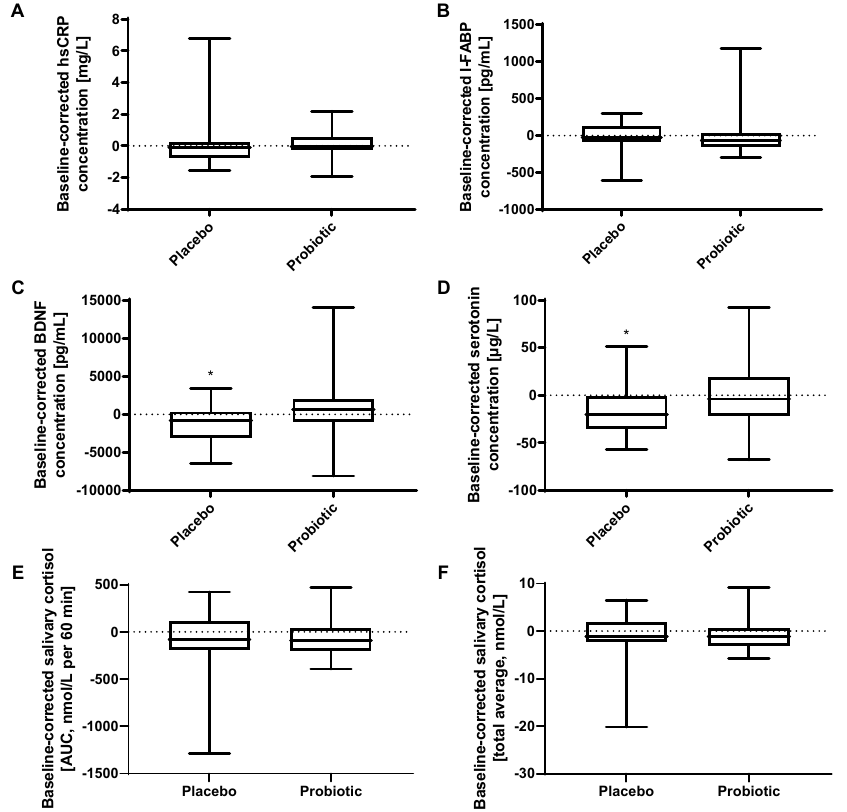
Figure 3. Effect of probiotic intervention on biomarkers. Baseline-corrected concentration of ( A ) high-sensitivity C-reactive protein in plasma, ( B ) intestinal fatty acid-binding protein in plasma, ( C ) brain-derived neurotrophic factor in serum, ( D ) serotonin in serum. Salivary cortisol awakening response calculated as ( E ) area under the curve and ( F ) total average. Line presents median, box presents 25th and 75th percentile, whiskers present minimum and maximum, * p < 0.05 for the comparison before vs. after intervention.